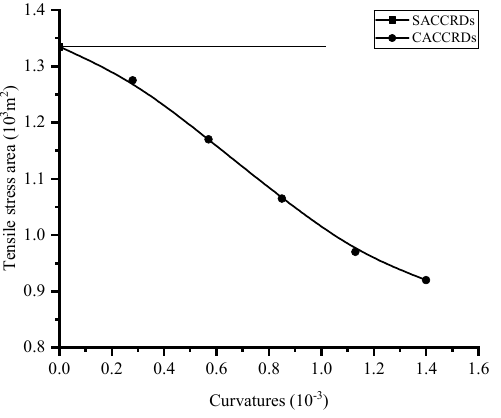
Figure 31. Relationship between tensile stress maximum of CACC and curvature of CACC.